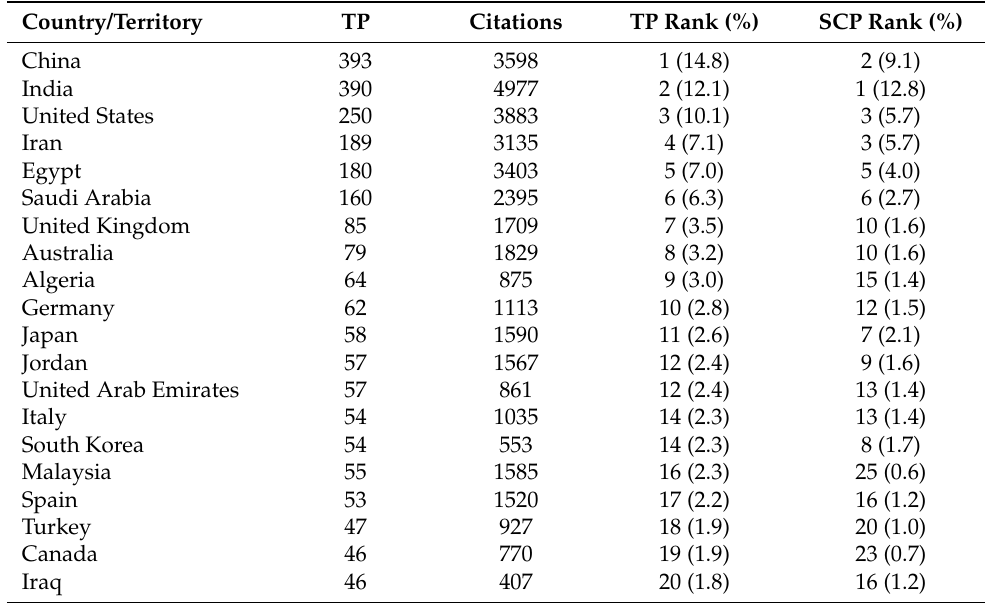
Table 4. The 20 most productive countries and rank by number of